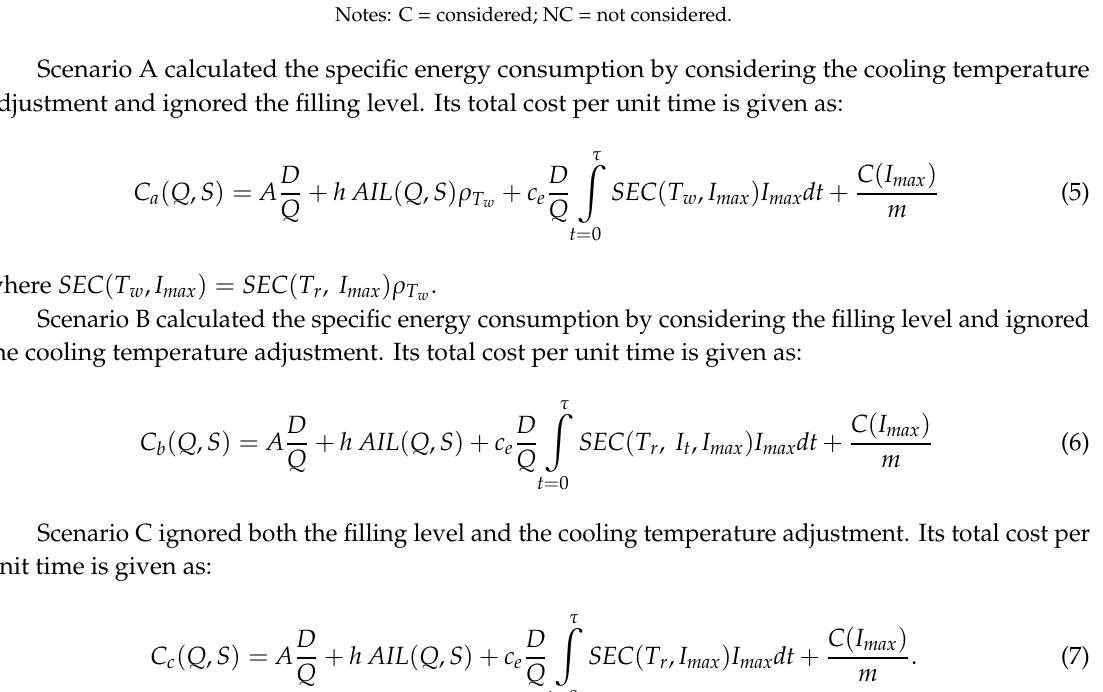
Table 2. Optimal values of the decision variables and the total cost TC ( Q ∗ , S ∗ ) for di ff erent scenarios. ∆ is the percentage errors in total cost from not considering the filling level and / or temperature adjustment. Temperature Filling Level Q * S * TC ( Q * , S * ) ∆ This study C C 371 1629 $24,415.36 Scenario A C NC Scenario B Scenario C